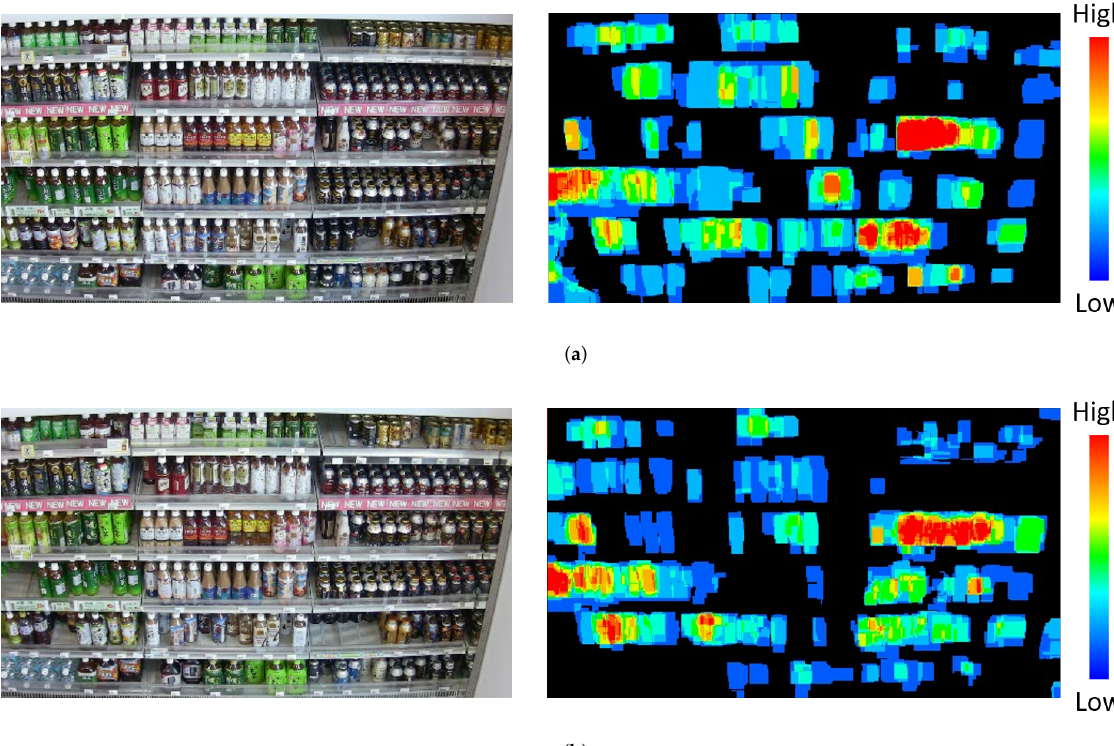
Figure 20. Examples of another application using our method. ( a ) Result for video 1. ( b ) Result for video